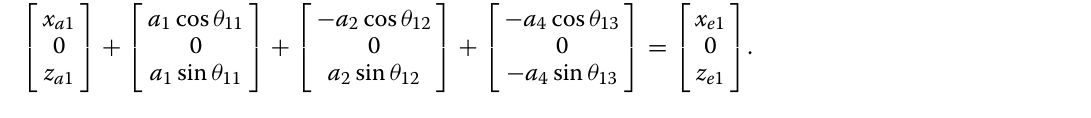
Figure 4. The four vector combinations OA 1 , A 1 C 1 , C 1 B 1 , B 1 O are selected as the closed-loop.